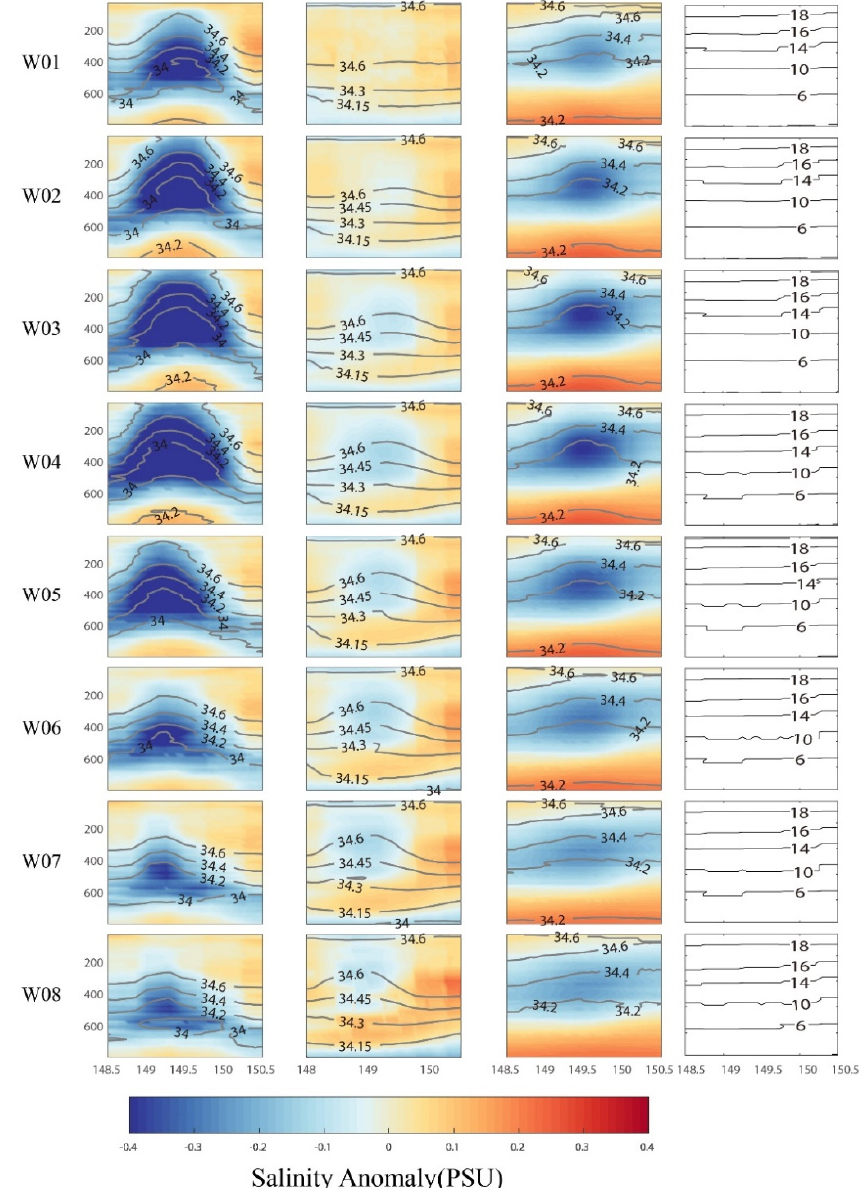
Figure 7. Sectional salinity distributions along the eight in situ sections. The horizontal axis is longitude and vertical axis is depth. The first column shows the salinity anomalies measured by MVPs, the second column shows ARMOR 3D salinity anomalies, and the third column shows the composite density anomalies, the fourth column shows the CARS09 (climatology) density. The gray lines represent the isohalines, and the color shading illustrates the salinity anomalies.